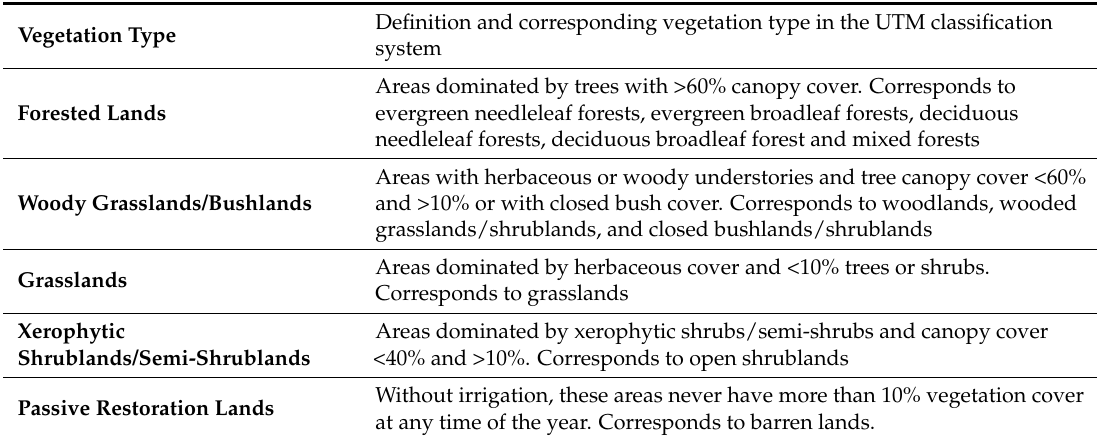
Table 1. Definitions of the vegetation restoration zones used in the newly designed